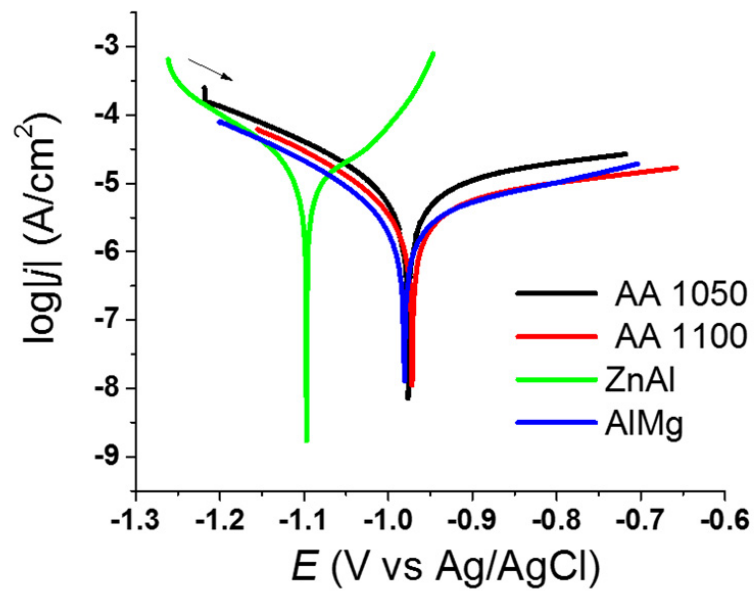
Figure 4. Polarization curves of Al/Zn alloys in artificial seawater. Table 4. Corrosion parameter from polarization curves of TS samples in artificial seawater. The error for j corr and b a,c is estimated at ± 20%, while that on E corr is ± 1 mV. Coating